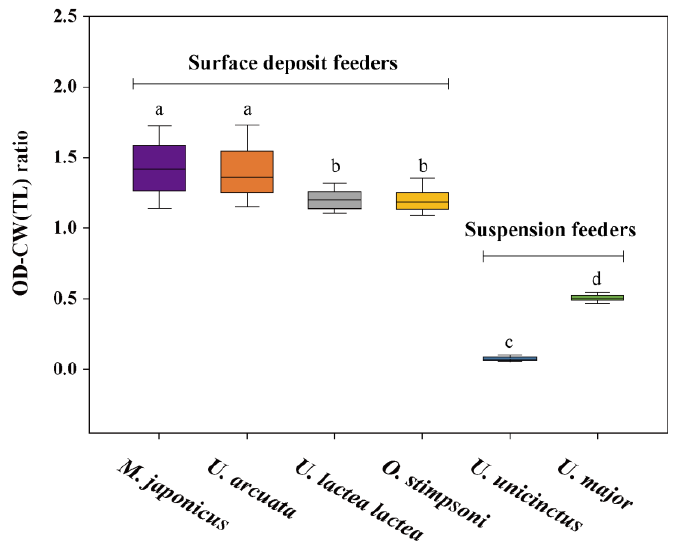
Figure 6. Box and whisker plot showing the OD – CW (TL for U. unicinctus ) ratios of six macroinvertebrate species. Different letters indicate the significant differences among species at 0.05.